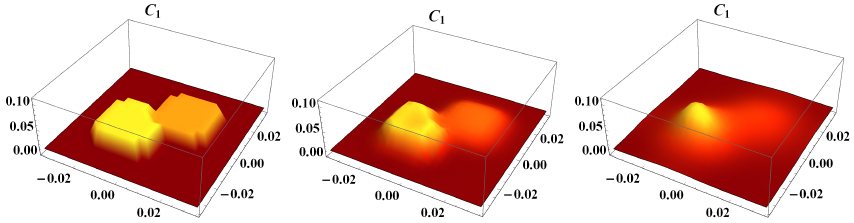
Figure 3. Distributions of Ni concentration c 1 for the times 0, 7 and 28 days respectively.